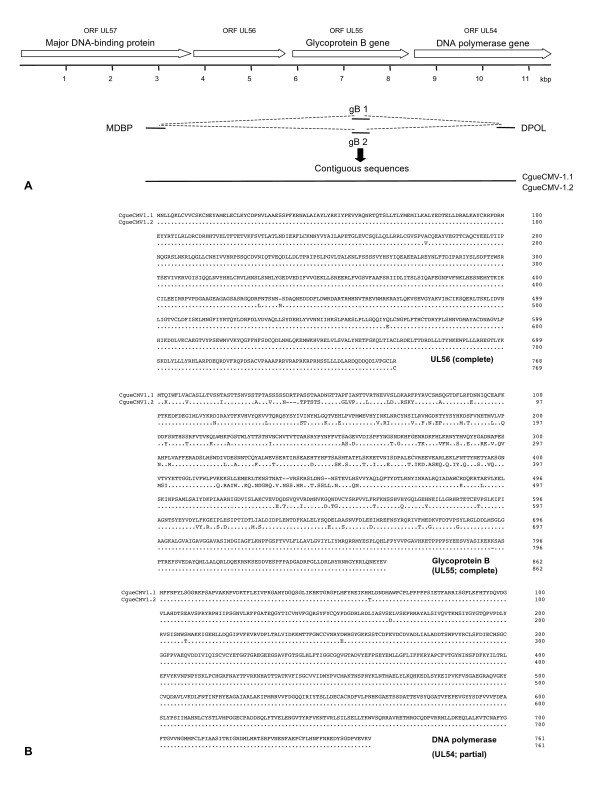
Amplification of an 8 kbp locus of CgueCMV-1.1 and CgueCMV-1.2. At the top of the figure, the betaherpesvirus ORFs UL57 (MDBP) to UL54 (DPOL) are depicted by open arrows. (A) The partial sequences of the ORFs UL57, UL55 and UL54, obtained through PCR with deg/dI primers, are depicted by thin solid lines, and the type of gB sequence (gB1 or gB2) is indicated. LD amplimers are depicted by dashed lines. The solid line represents the final 8 kbp contiguous sequences of CgueCMV-1.1 and CgueCMV-1.2. (B) Pairwise alignments of the UL56 and gB proteins and the partial DPOL proteins of CgueCMV-1.1 and CgueCMV-1.2 are shown. Dots represent identical amino acids, dashes indicate regions of non-colinearity.